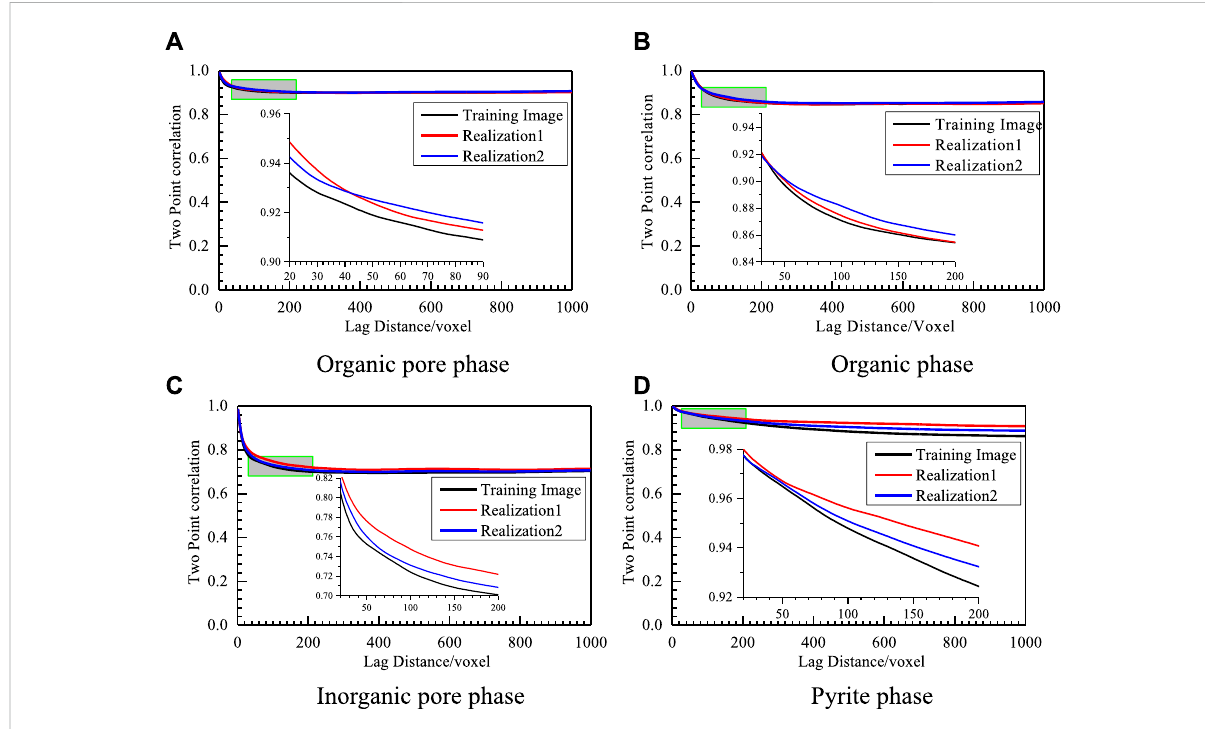
FIGURE 13 Differentphasestwo-pointcorrelationfunctions (A) Organicpore, (B) organic, (C) inorganicporephase,and (D) pyritephase.Itshouldbenoted that the images were obtained by segmenting the reconstructed gray